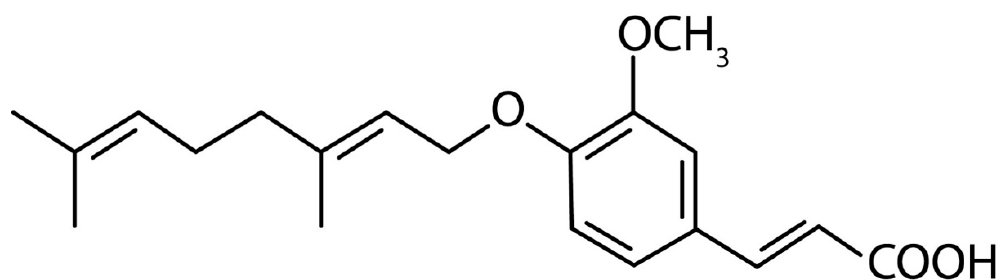
(cid:48) -geranyloxy-3 (cid:48) -methoxyphenil)-2-trans propenoic acid Figure 1. Chemical structures of 3-(4 ′ -geranyloxy-3 ′ -methoxyphenil)-2-trans propenoic acid (GOFA). Figure 1. Chemical structures of 3-(4